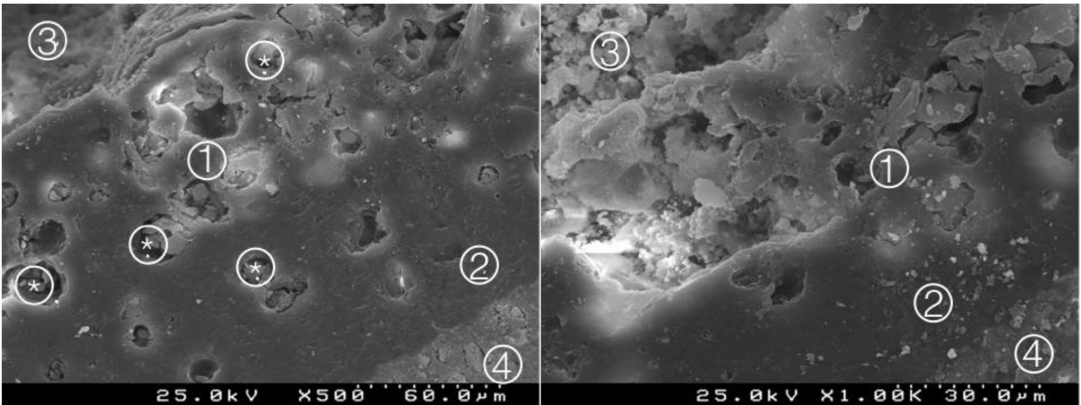
Figure 11. Group 9 (NeoMTASE0I): deep interdiffusion between the adhesive and the cement, with particles of cement involved by the adhesive (*). A thick hybrid layer is observed 1 (cid:13) between the adhesive 2 (cid:13) and the NuSmile ® NeoMTA 3 (cid:13) . Composite resin 4 (cid:13) (original magnification 500 × and 1000 × ).